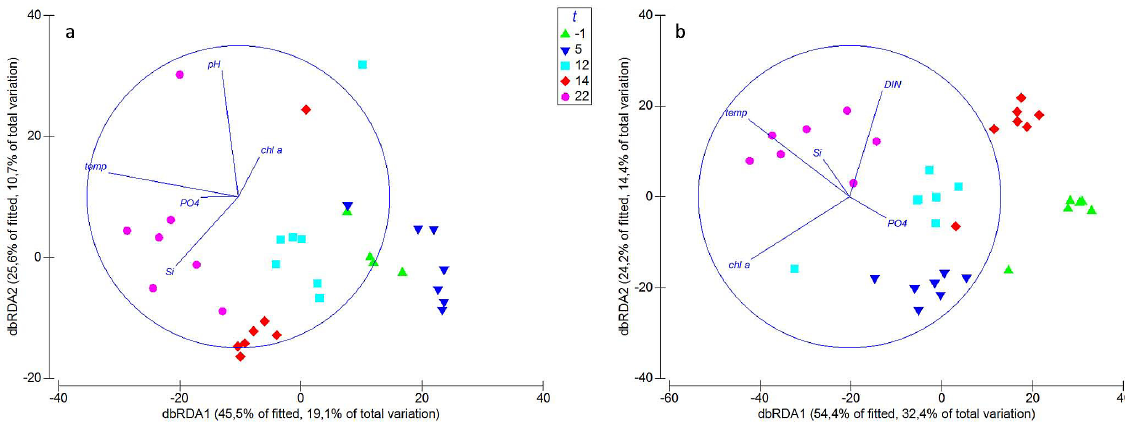
Fig. 1. Distance-based redundancy analyses (dbRDA) for (a) particle-associated bacteria and (b) free-living bacteria. Symbols distinguish experiment days ( t ).